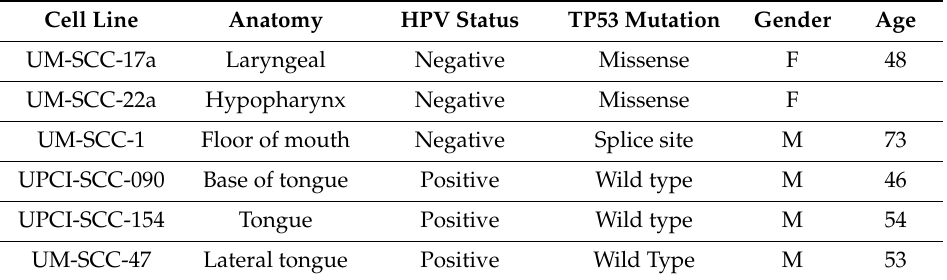
Table 1. HNSCC cell line